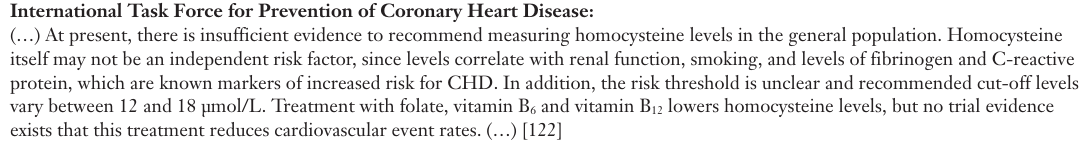
Table 4 Recommendations for screening, prevention and treatment of hyper-